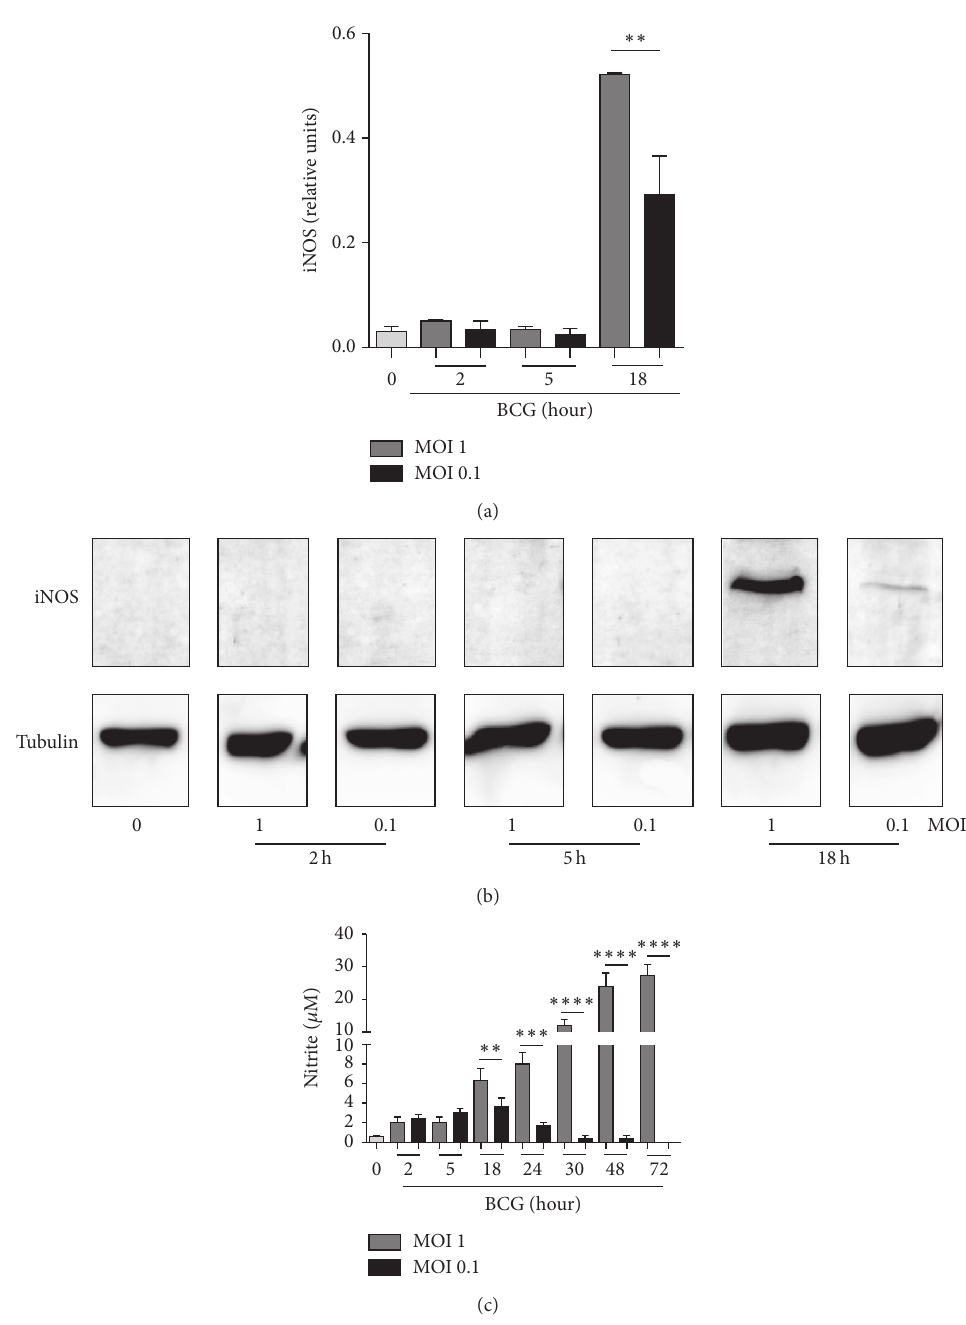
Figure 6: BCG infection at MOI 1 and MOI 0.1 induces iNOS and NO production but only MOI 1 maintains this function for long time. RAW macrophages were infected with BCG Pasteur at MOI 1 and MOI 0.1. (a) Cells were recovered at 2, 5, and 18h after infection and iNOS expression was evaluated by western blot. Band densities were normalized against tubulin by densitometry analysis. Results are shown in relative units of concentration using IMAGEJ software. (b) Representative western blot for iNOS and tubulin as a loading control. (c) Nitrite was evaluated in culture supernatant from each condition using Griess reagent. Two-tailed unpaired Student’s 𝑡 -test was used to evaluate differences versus uninfected cells. Bars indicate mean ± SEM from three (a) or five (c) independent experiments. ∗∗∗∗ 𝑃 < 0.0001 , ∗∗∗ 𝑃 < 0.001 , and ∗∗ 𝑃 < 0.01 . Grey bar refers to uninfected cells indicated by